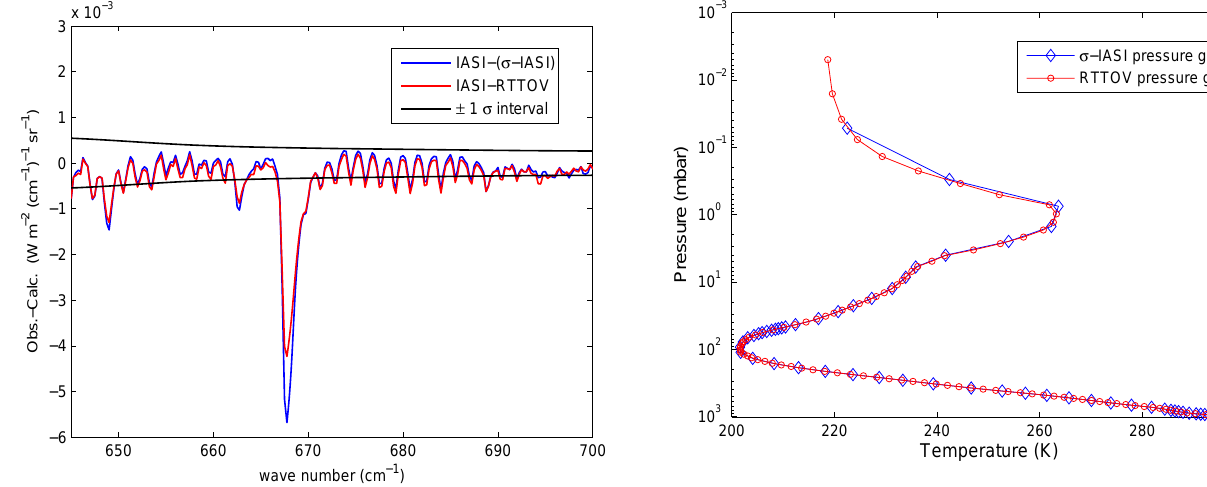
Fig. 7. Spectral residual averaged over the 25 IASI soundings. The input state vectors have been obtained by the dropsonde+ECMWF data. The residual has been computed based on the two forward models σ -IASI and RTTOV.